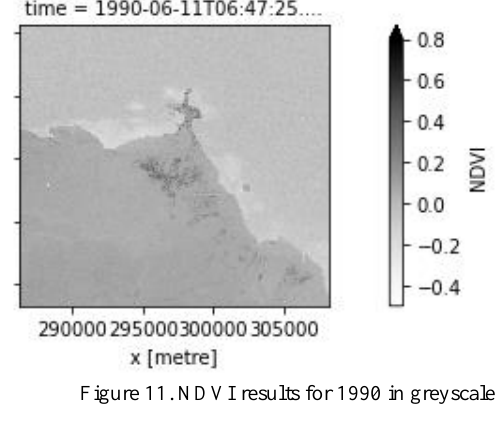
Figure 11. NDVI results for 1990 in greyscale.